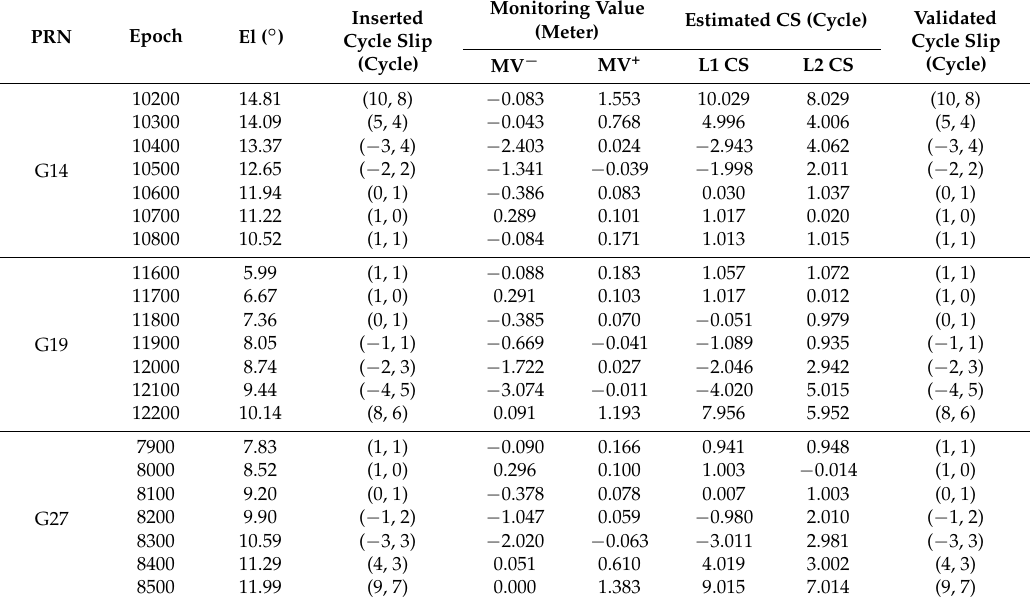
Figure 12. Cycle-slip detection results for G27. Table 5. Cycle-slip detection and compensation results.